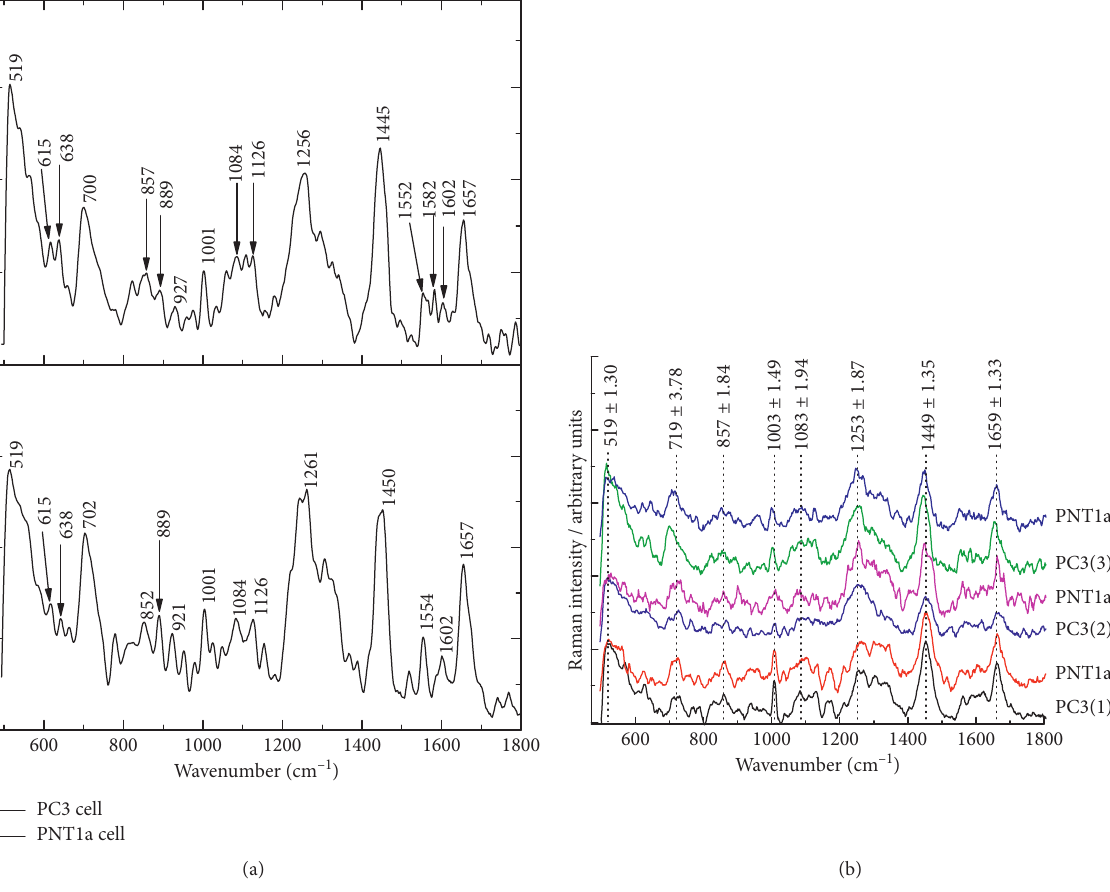
Figure 2: (a) Examples of as-collected raw spectra in PC3 and PNT1a cells; (b) the stacked mean spectra of samples according to the stages of cell proliferation. The spectra shown in part (b) have been linearly offset for comparison. The numbers (1, 2, 3) enclosed in brackets identify stage 1 (48 hours), stage 2 (72 hours), and stage 3 (96 hours) spectral measurements.